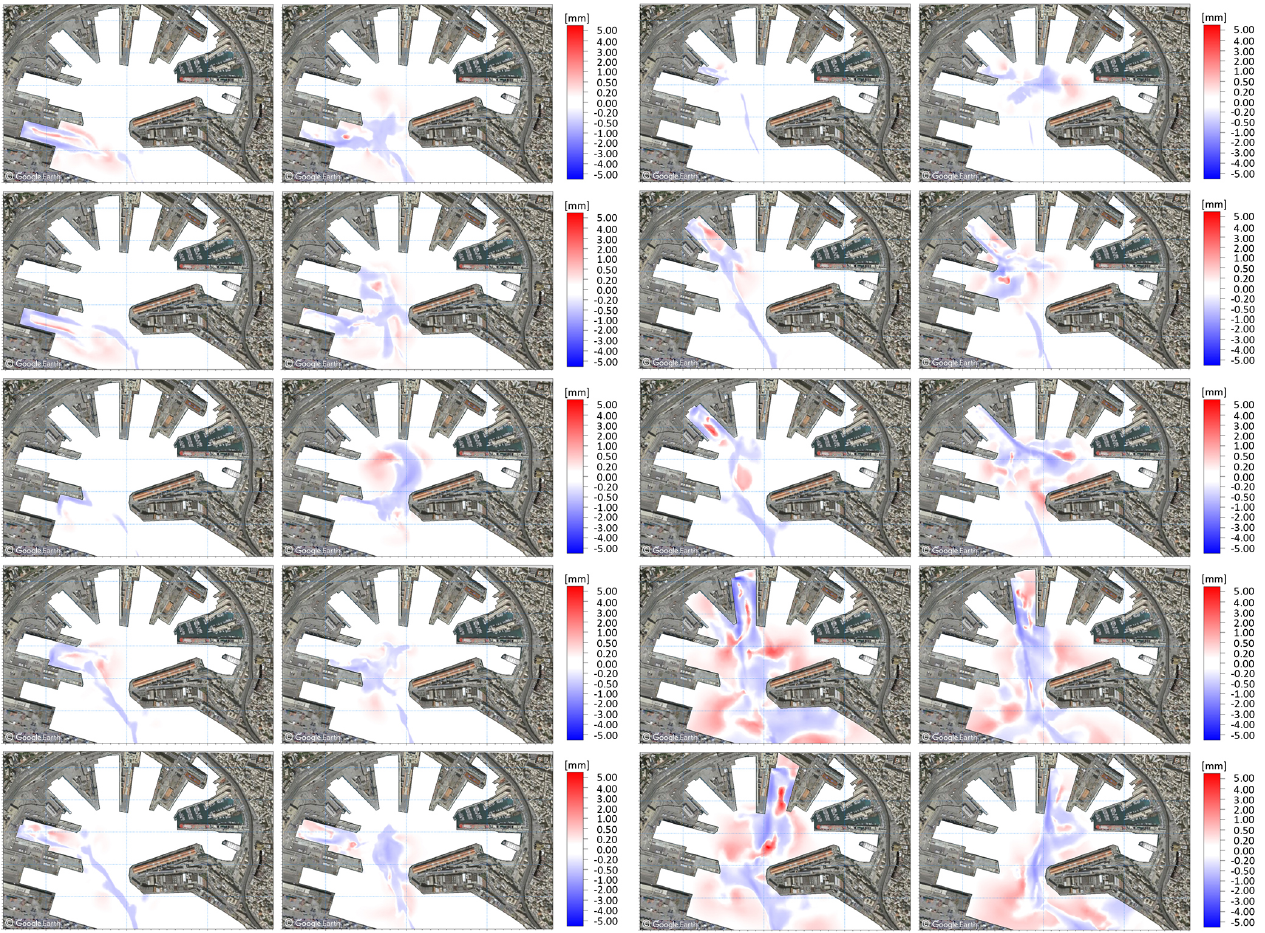
Figure C1. Sediment erosion and accumulation for the scenarios of docks T1, T2, T3, T5, and T6 (left, top to bottom) and for the scenarios of docks T9, T10, T11, DL, and 1003 (right, top to bottom). Land background from © Google